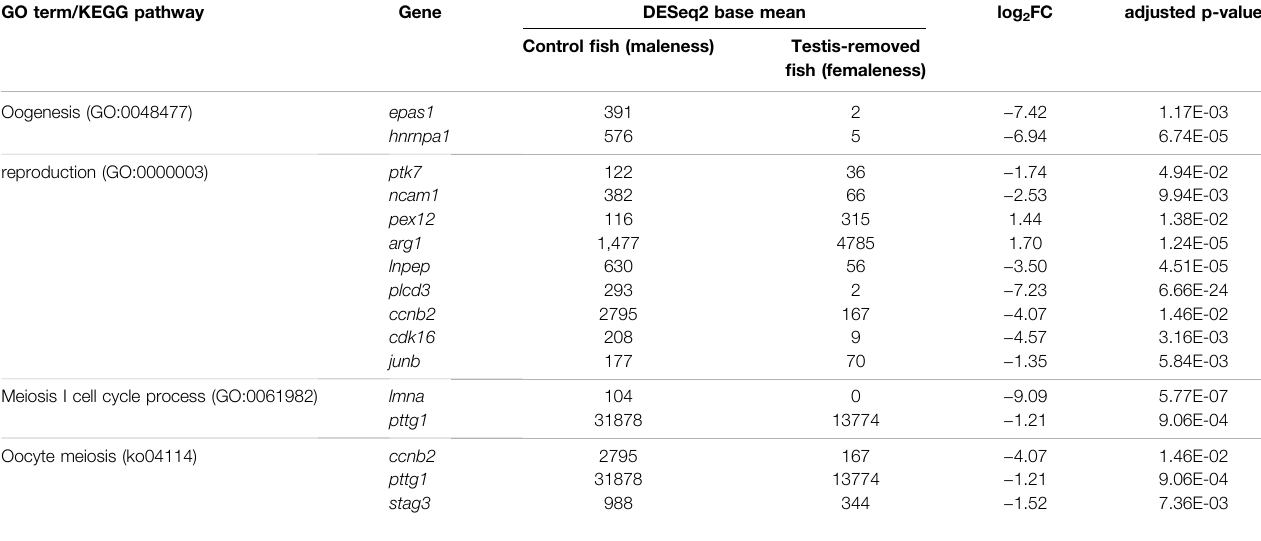
TABLE 4 | The candidate DEGs (differentially expressed genes) involved in GO (Gene Ontology) terms and KEGG (Kyoto Encyclopedia of Genes and Genomes) pathway. log 2 FC = log 2 fold